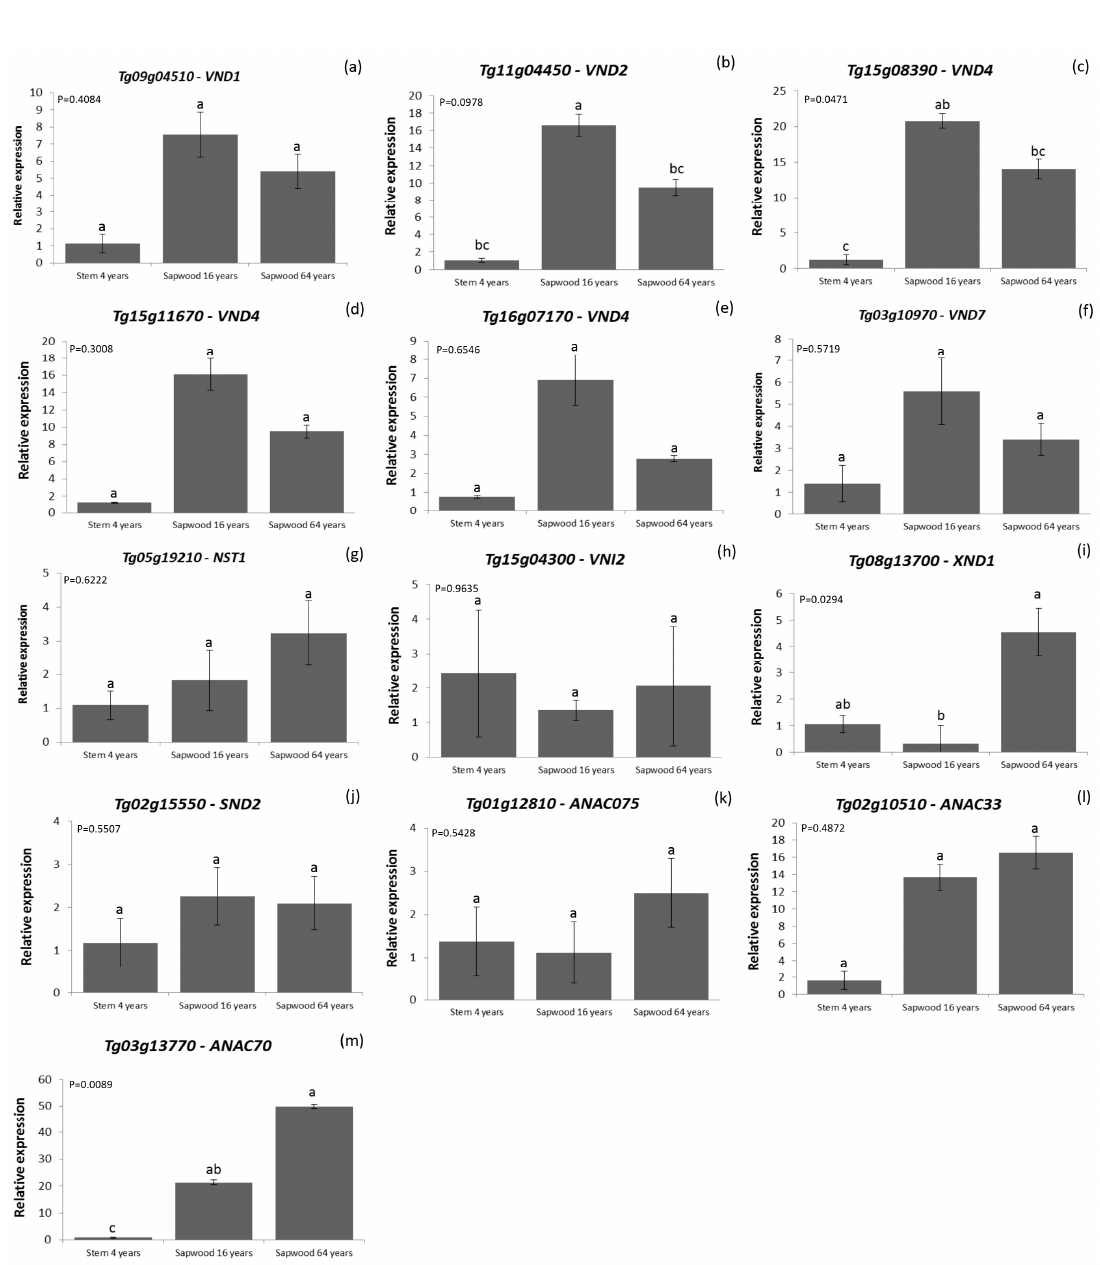
Figure 5. Expression levels of selected TgNAC genes using RT-qPCR. The relative expression of 13 selected NAC genes of T. grandis was normalized to the reference gene TgEF-1 α in stem of 4-year-old trees and sapwood of 16- and 64-year-old trees. Bars represent standard errors (SEs) of three biological replicates and two technical replicates. The p -values are shown, and di ff erent letters represent statistically di ff erent means. Relative expression of the genes: ( a ) VND1-Tg09g04510, ( b ) VND2-Tg11g04450, ( c ) VND4-Tg15g08390, ( d ) VND4-Tg15g11670, ( e ) VND4-Tg16g07170, ( f ) VND7- Tg03g10970, ( g ) NST1-Tg05g19210, ( h ) VNI2-Tg15g04300, ( i ) XND1-Tg08g13700, ( j ) SND2- Tg02g15550, ( k ) ANAC075-Tg01g12810, ( l ) ANAC33-Tg02g10510, ( m ) ANAC70-Tg03g13770 .